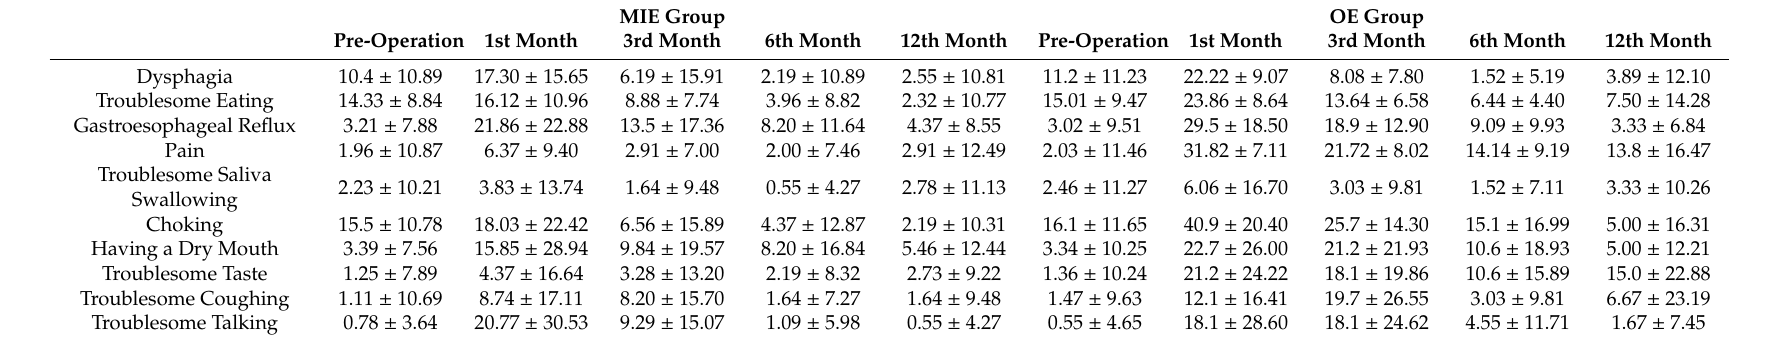
Table 4. The comparison of OES18 between the two